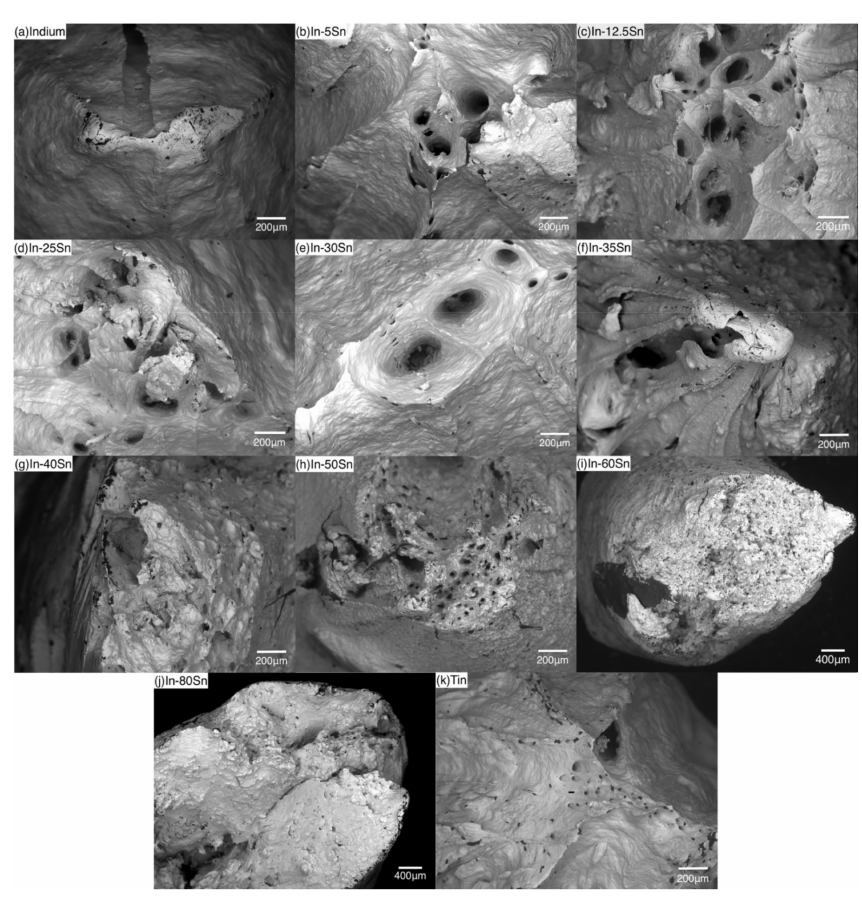
Figure 6. ( a – k ) Representative top view fracture surfaces of tested samples from 0 wt% Sn content to 100 wt% Sn content, where Figure ( i ) In-60Sn and ( j ) In-80Sn are under × 40 magnification and the rest of images are under × 100